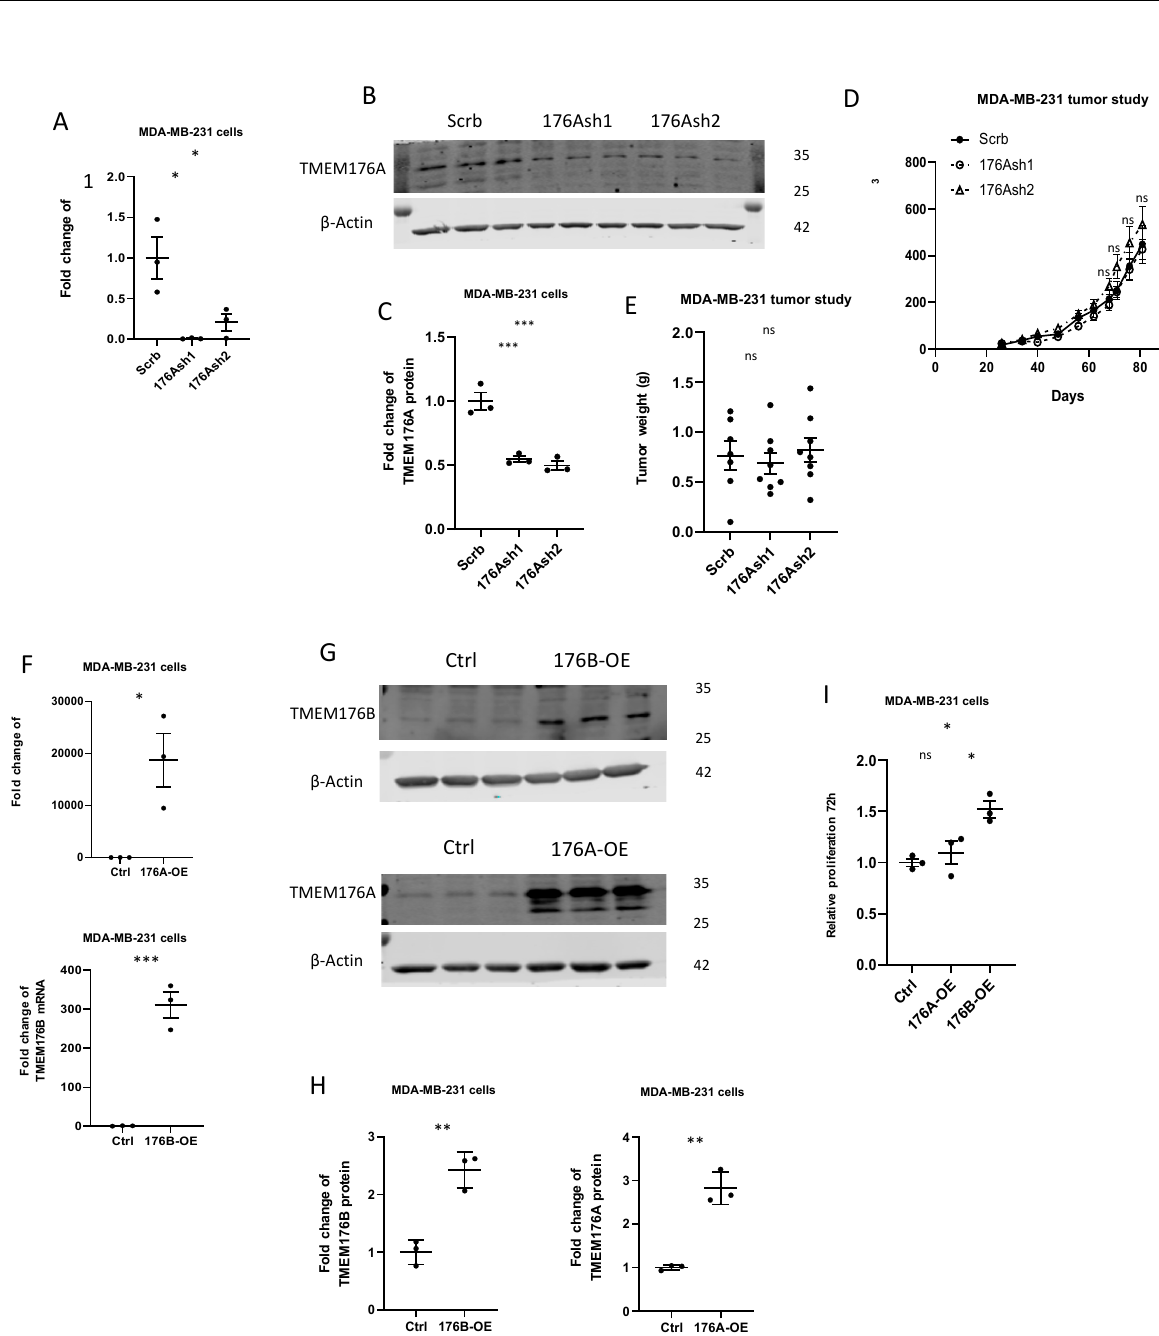
Figure 3. TMEM176B but not TMEM176A affected cell proliferation and tumor growth. ( A ) TMEM176A mRNA expression was evaluated by qRT-PCR in control (Scrb) and TMEM176A-silenced (176Ash1, 176Ash2) MDA-MB-231 cells (n = 3 per group, with two independent experiments). ( B , C ) Representative Western blot image and quantification of TMEM176A protein expression (n = 3 per group, with three independent experiments). ( D ) Growth charts of MDA-MB-231 control (Scrb), and TMEM176A-silenced (176Ash1 and 176Ash2) tumor xenografts in the Rag1 − / − female mice (n = 6–8 mice per group). ( E ) Tumor weight at the end of the study. ( F ) TMEM176A and TMEM176B mRNA expression was evaluated by qRT-PCR in control (Ctrl) and TMEM176A-overexpressing (176A-OE) or TMEM176B-overexpressing (176B-OE) (n = 3 per group, with two independent experiments). ( G , H ) Representative Western blot image and quantification of TMEM176A and TMEM176B protein expression (n = 3 per group, with three independent experiments). ( I ) Proliferation assay of control (Ctrl) and TMEM176A- and TMEM176B-overexpressing MDA-MB-231 cells after 96 h (n = 3 per group in one independent experiment). Data are presented as means ± SEM. Differences between groups were evaluated by Student’s t-test ( F , H ) and the one-way ( A , C , E , D , I ) ANOVA test with the Bonferroni post hoc test. * p < 0.05. ** p < 0.01. *** p < 0.001. ns: not significant.